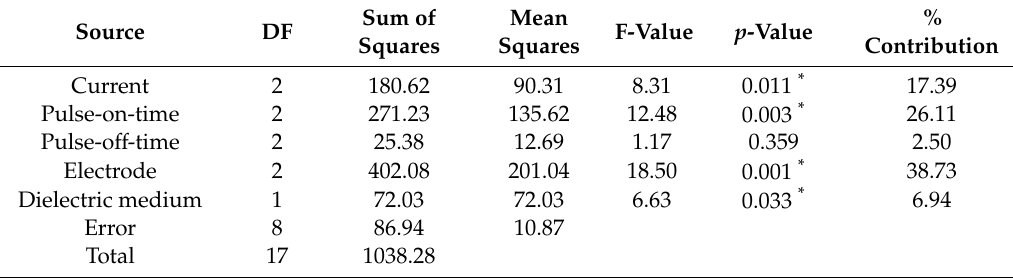
Table 5. ANOVA for Surface